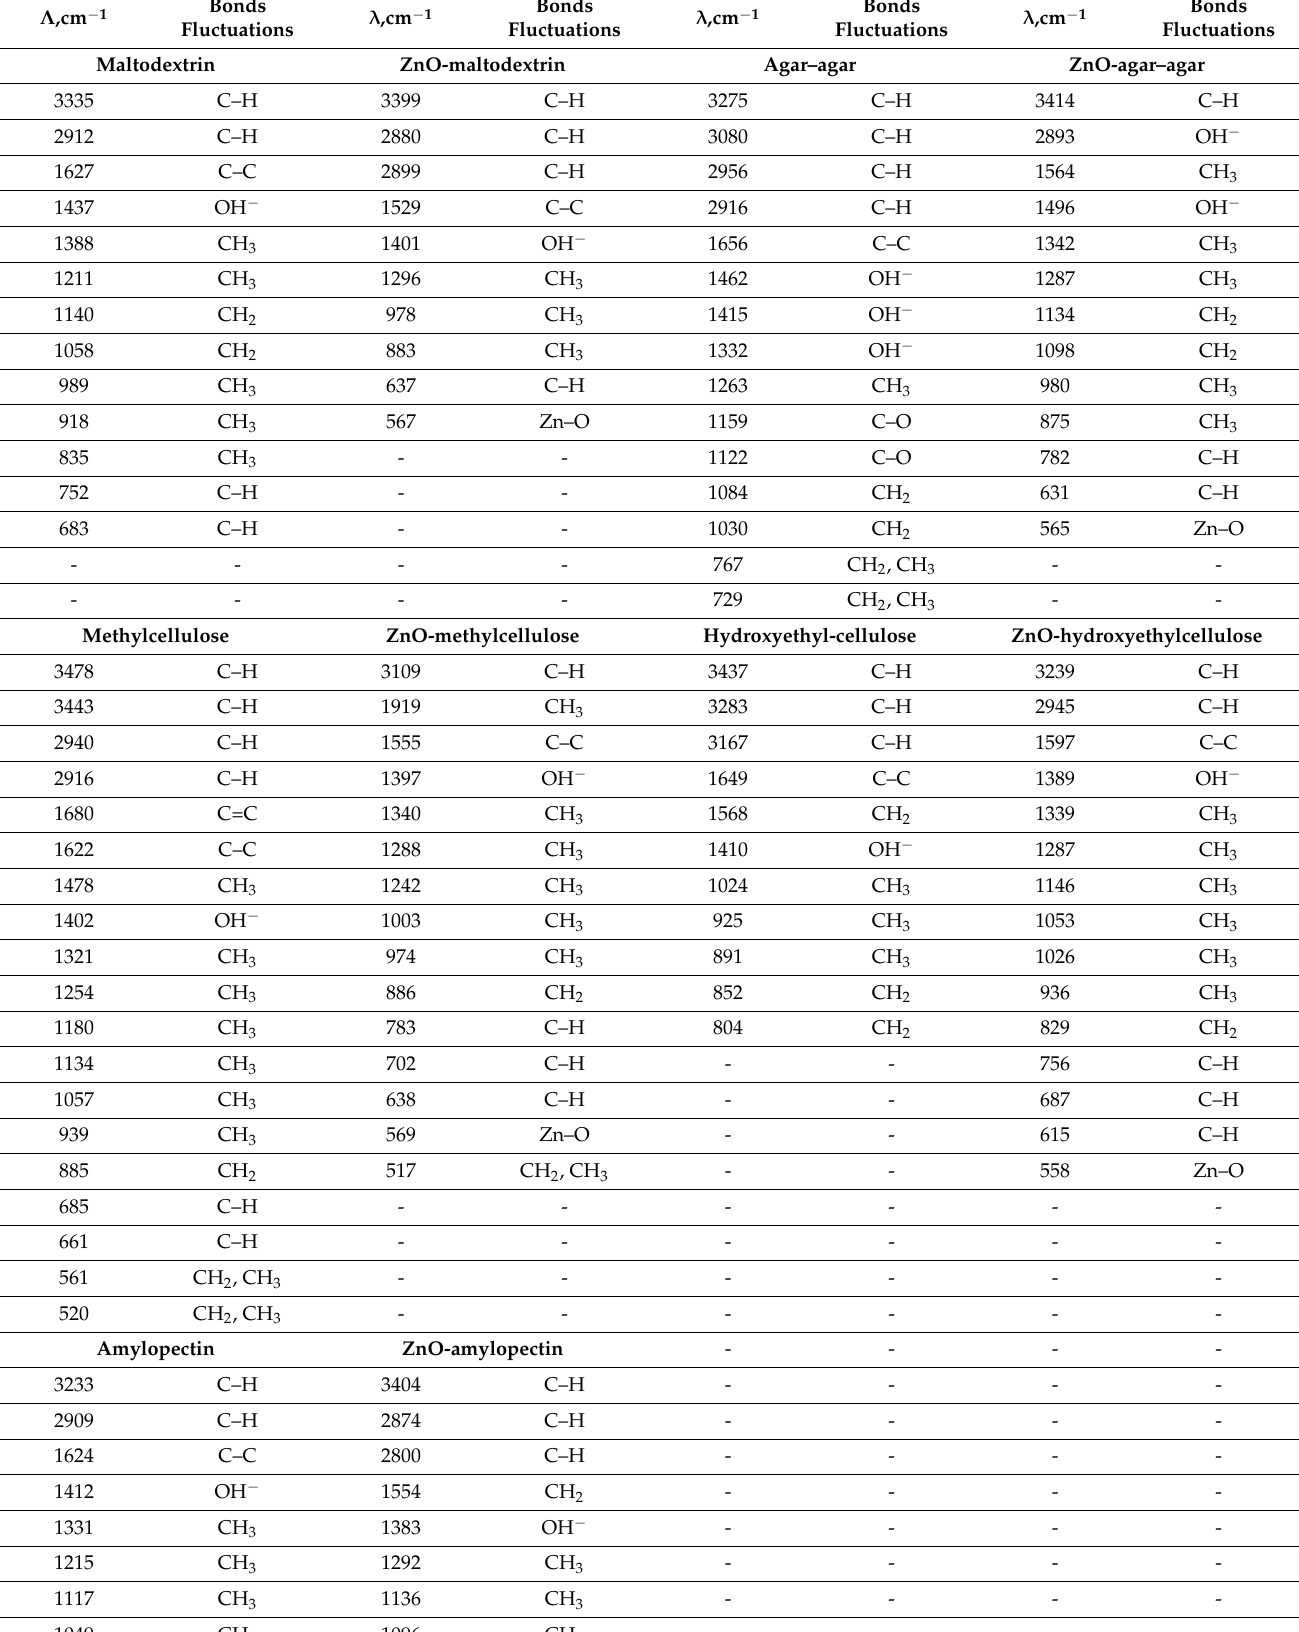
Table 3. IR spectroscopy